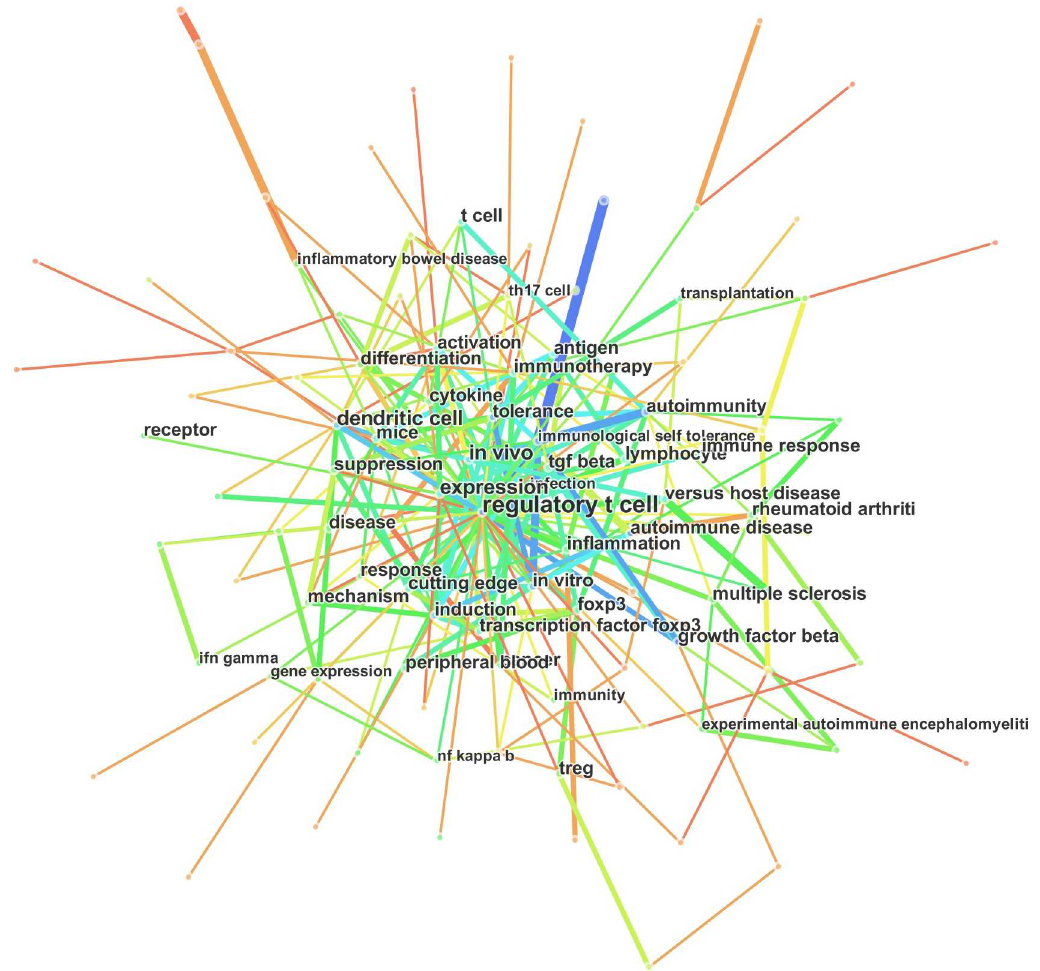
Fig 9. Map of keyword co-occurrence in articlesrelatedto regulatory T cell (Treg) research published from 2000 to 2015.